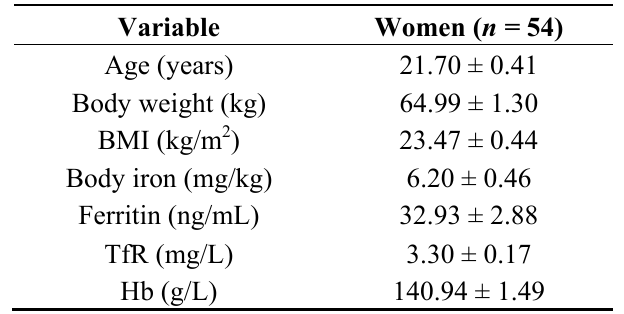
Table 5. Baseline characteristics of all women